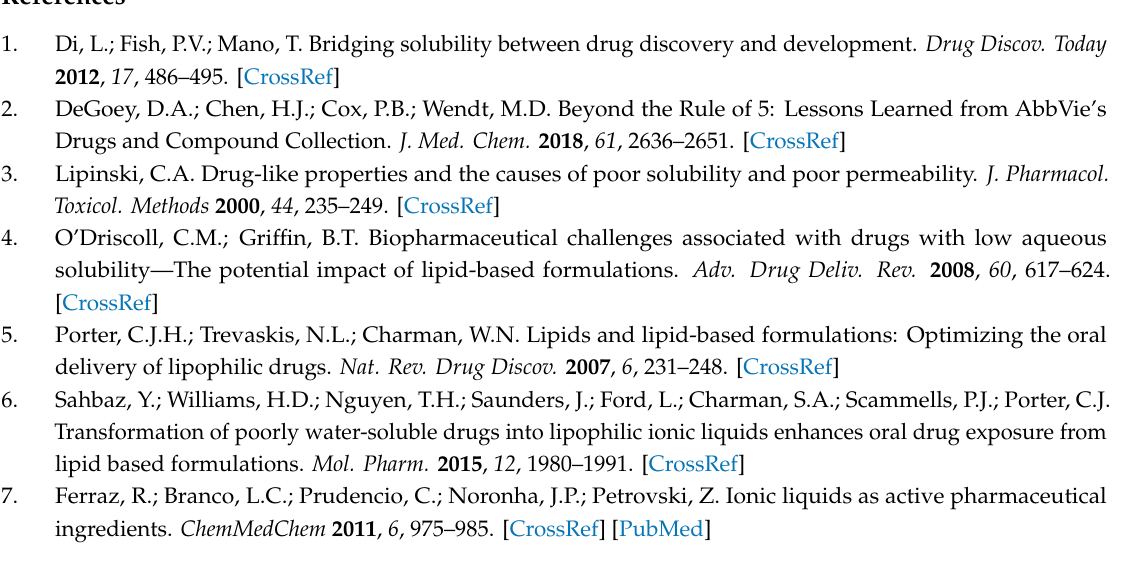
Figure S1: DSC of venetoclax batches. Given are the melting temperatures and enthalpy of fusion (mean ± SD; n = 3). Figure S2: Hot-stage microscopy of venetoclax batch 1 under cross-polarised light. Pictures were taken at various temperatures during heating from room temperature to 165 ◦ C (10 ◦ C / min) and during cooling to 25 ◦ C (20 ◦ C /